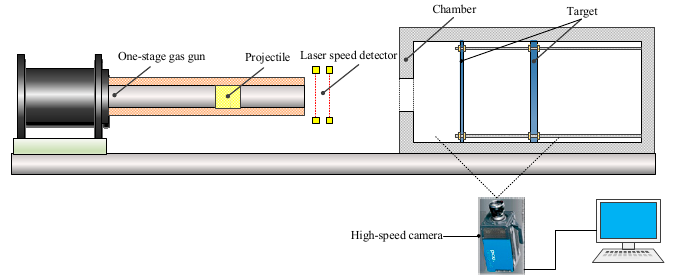
Figure 1. Schematic diagram of experimental setup.